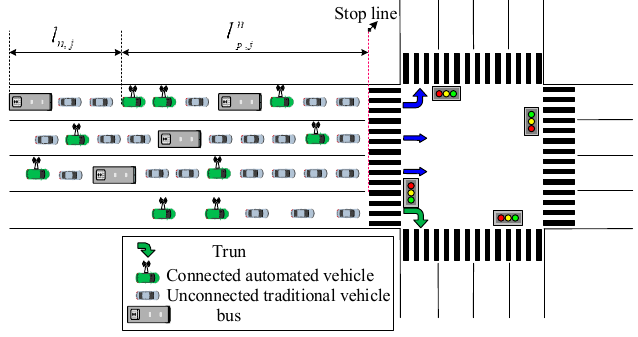
Figure 3. Schematic diagram of Shockwave estimation model.